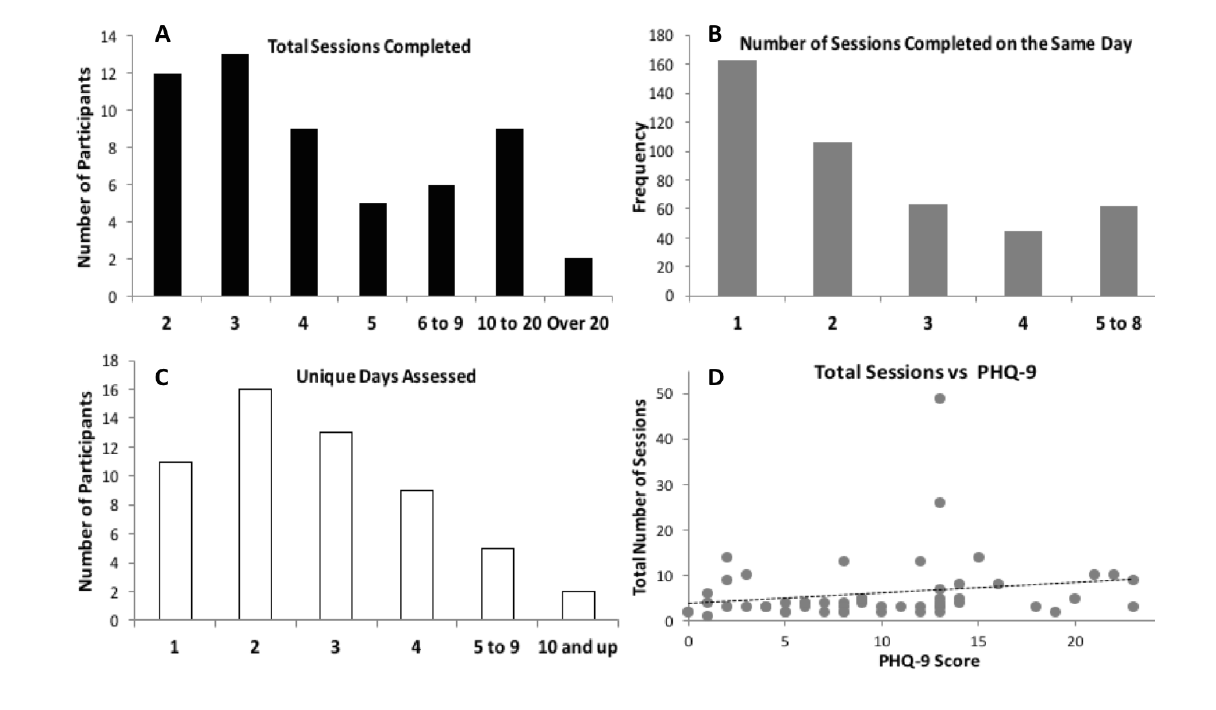
Figure 4. Repeated IMS data frequency. IMS data was collected within days and across days for 56 participants. (A) A histogram showing the total number of sessions completed by participants. (B) Number of sessions completed on the same day (multiple sessions for participants). (C) A histogram showing the unique days of IMS assessments completed by participants. (D) Total number of sessions completed as a function of baseline PHQ-9 score (r=.18, P=.18). PHQ-9: patient health questionnaire, 9-item. IMS: Immediate Mood